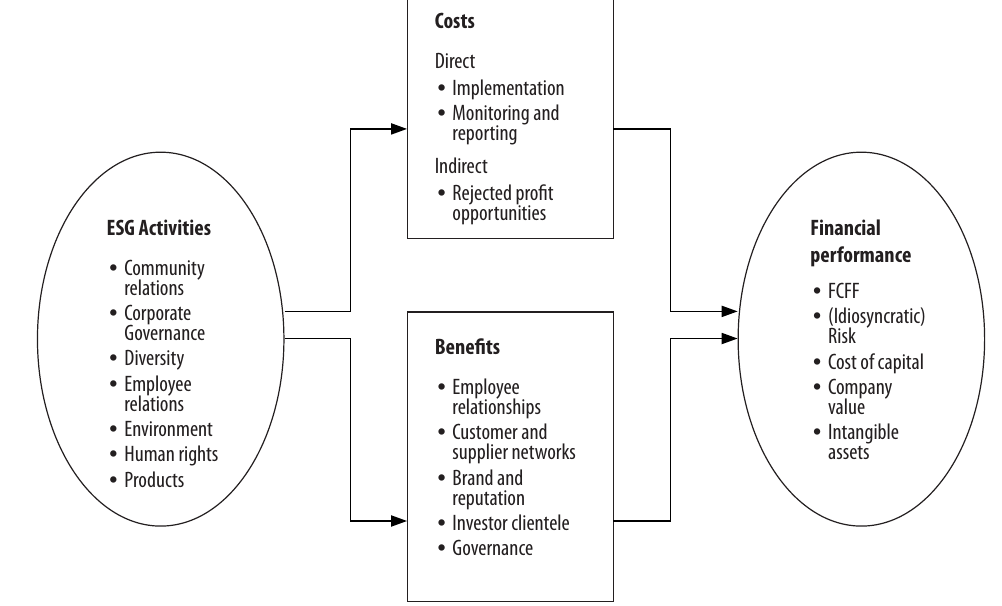
Fig. 1. Costs and benefits of an active ESG